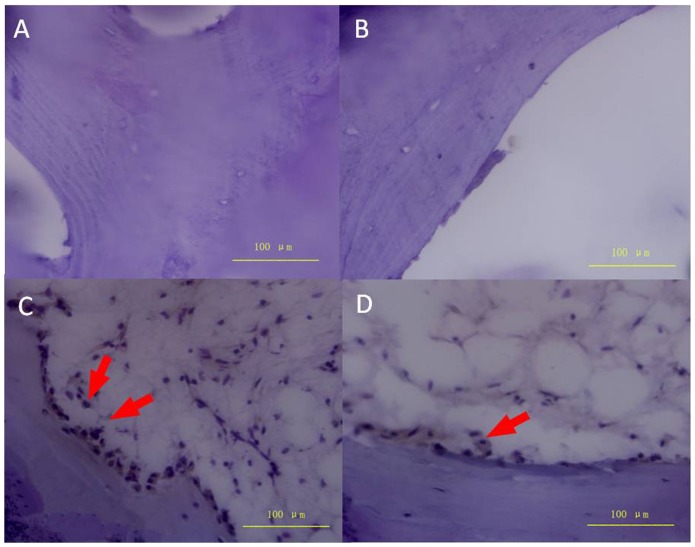
Histology of alkaline phosphatase (ALP) staining.A reduced number of ALP-positive cells were observed in the subchondral bone (A) and necrotic regions (B). Red arrows indicate ALP-positive cells in the sclerotic (C) and healthy (D) regions.